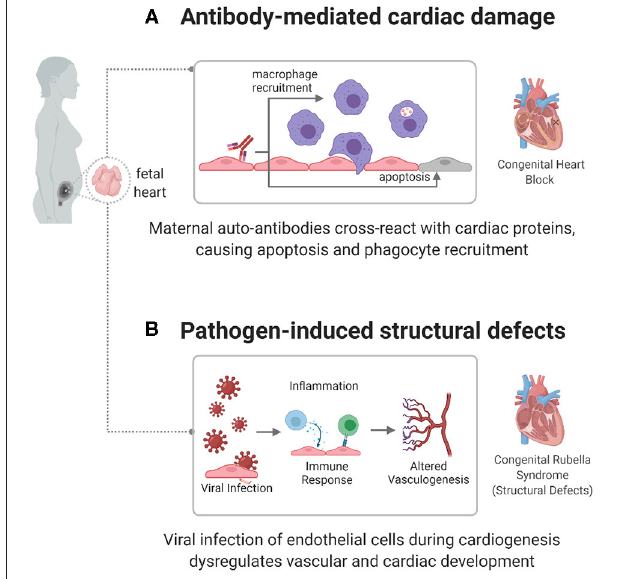
FIGURE 2 | Immune mechanisms causing congenital heart disease. autoimmune and infectious causes have been identified as factors in the development of some CHDs, including congenital heart block (CHB) and congenital rubella syndrome. (A) In CHB, maternal autoantibodies target fetal cardiac proteins, causing conductive tissue damage. (B) In congenital rubella syndrome, the virus can target endothelial cells during cardiogenesis, preventing normal developmental processes and creating structural